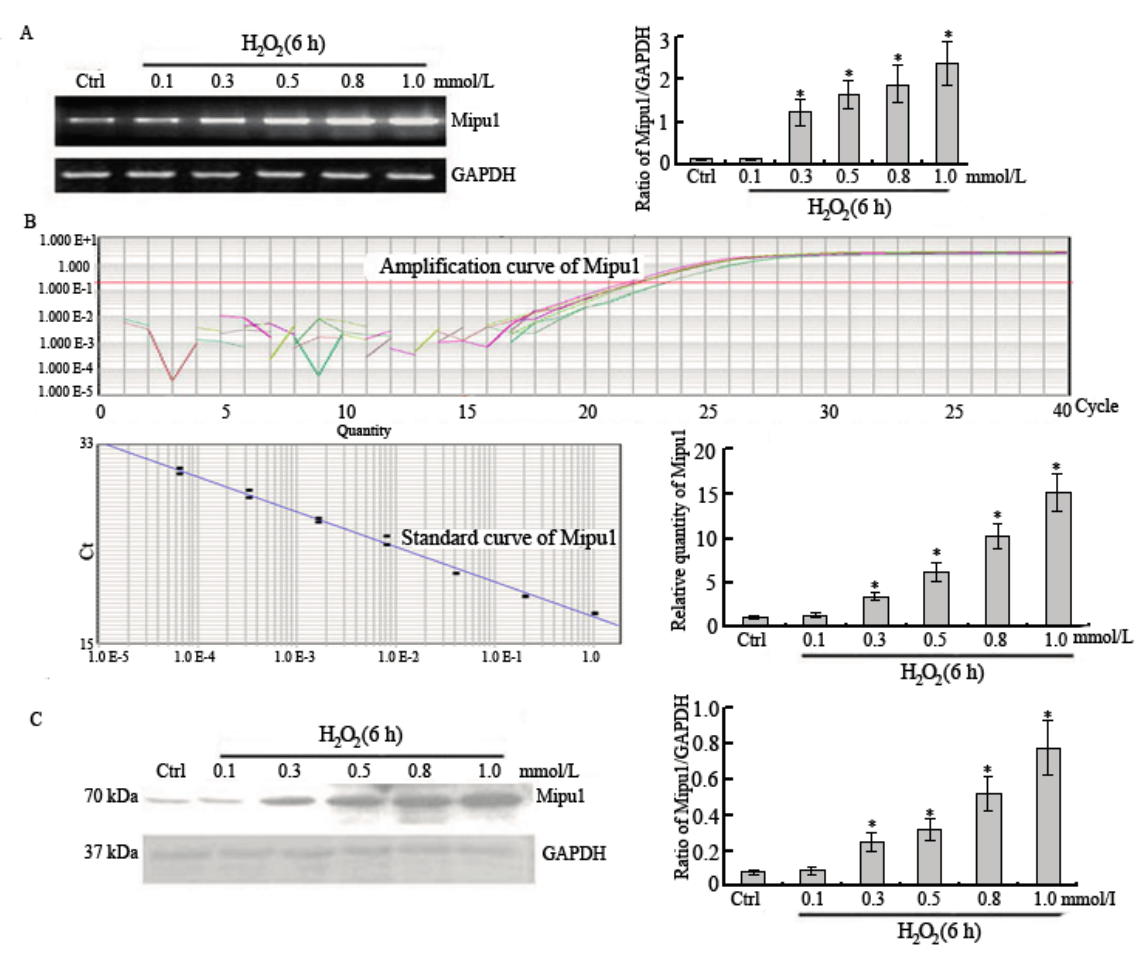
Figure 2. Expression of Mipu1 in H 2 O 2 -stimulated H9c2 myogenic cells at indicated doses for 6 h. ( A ) mRNA levels of Mipu1 were determined by RT-PCR; ( B ) mRNA levels of Mipu1 were determined by quantitative real-time RT-PCR; ( C ) Protein levels of Mipu1 were determined by Western blotting assay. The relative values of all results were determined and expressed as mean ± SEM of three experiments induplicate. *, p < 0.05, vs. control